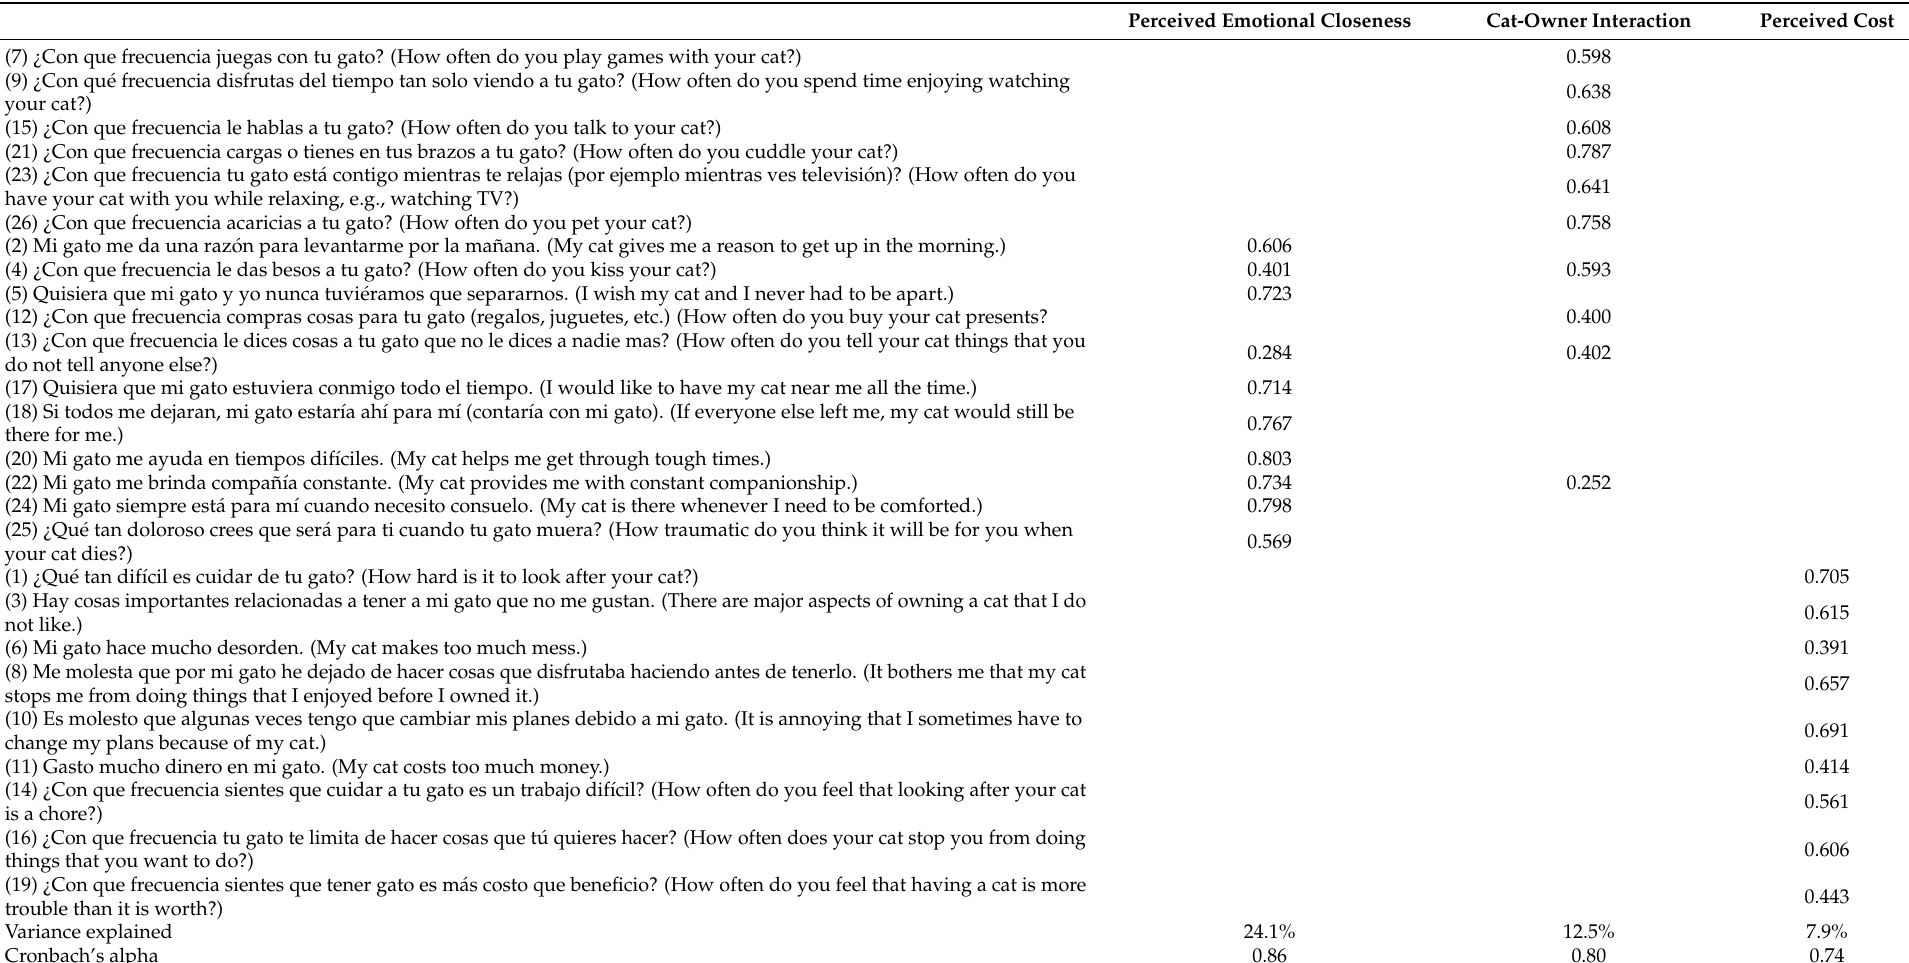
Table 2. Exploratory factor analysis for the